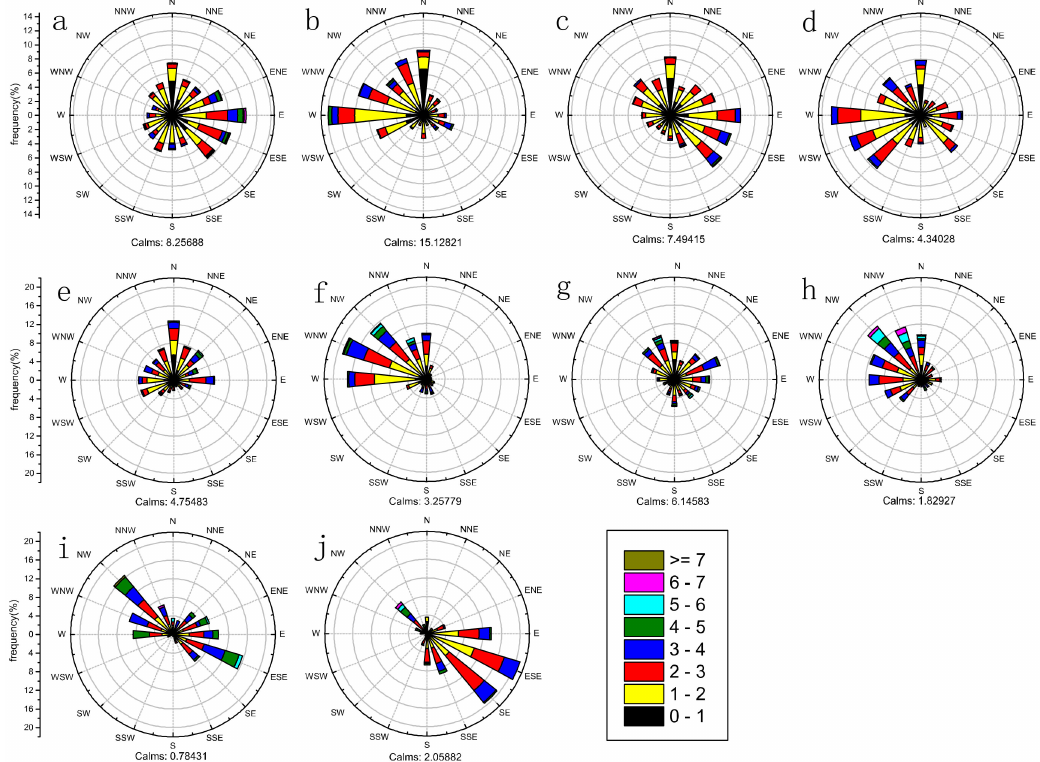
Figure 5. Wind-rose map of flow vector wind in ten types (( a ) EQP_nth, ( b ) EQP_sth, ( c ) EQP_sw, ( d ) EQP_cst, ( e ) ACF_nth, ( f ) ACF_sth, ( g ) ACF_sw, ( h ) ACF_cst, ( i ) INT_nth, ( j ) INT_sw). The